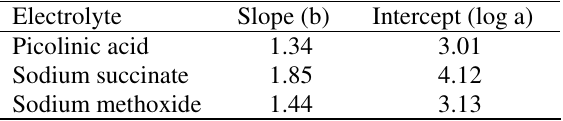
Table 1. Parameters in eq.(1) for zircaloy - 2.